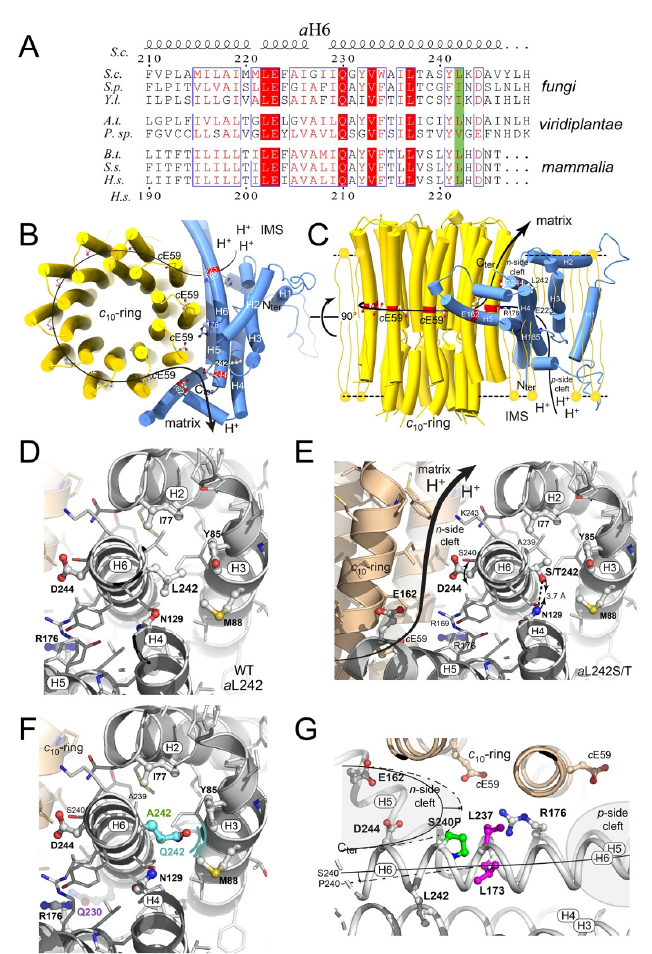
Figure 5. Evolutionary conservation and topology of a L242 and a L242S / T residues. ( A ) Amino-acid alignment of the C-terminal ∆Ψ -helix ( a H6) of subunits a from various mitochondrial origins: Saccharomyces cerevisiae ( S.c. ), Schizosaccharomyces pombe ( S.p. ), Yarrowia lipolytica ( Y.l. ), Arabidopsis thaliana ( A.t. ), Polytomella sp ( P.sp. ), Bos taurus ( B.t. ), Sus scrofa ( S.s. ), and Homo sapiens ( H.s. ). At the top and bottom, are numbered the residues in S.c. mature protein (i.e., without the first ten residues that are moved during assembly) and in the H.s. protein, respectively. Strictly conserved residues are in white on a red background while similar residues are in red on a white background with blue frames. The secondary structures of the S.c. protein marked above the alignment are according to [9]. Top view from the matrix ( B ) and side view ( C ) of the c 10 -ring and subunit a and the pathway along which protons are transported from the intermembrane space (IMS) to the mitochondrial matrix. The side chains of the two residues essential to this transfer ( a R176 and c E59), and of residues presumed to be important for this transfer, in the n-side cleft ( a H185, a E223) and in the p-side cleft ( a E162, a D244), and of a L242 are drawn as ball and stick. ( D ) The wild type a L242 residue is within a 4-helix bundle ( a H2, a H3, a H4 and a H6) in proximity to a I77, a Y85, a M88 and a N129. This bundle is disrupted with a L242P and fully preserved with a L242S and a L242T, which presumably involves the formation of a hydrogen bond between the hydroxyl group of a S242 or a T242 and the amide group of a N129 as depicted ( E ). The partial impairment of ATP synthase function with a S242 or a T242 is possibly caused by a local disturbance at the level of a D244 as indicated by the double arrowed curved trait (see Text). ( F ) In a L242A (green) and a L242Q (cyan) a cavity or clashes between neighboring helices preclude the helix bundle stability. ( G ) Schematic top view showing the probable bend of a H6 due to the a S240P mutation that should deepen the n -side pocket. The a H6 helix axis is drawn as a continuous (S240) and dashed (P240) line. For sake of clarity, only relevant side chains are depicted.